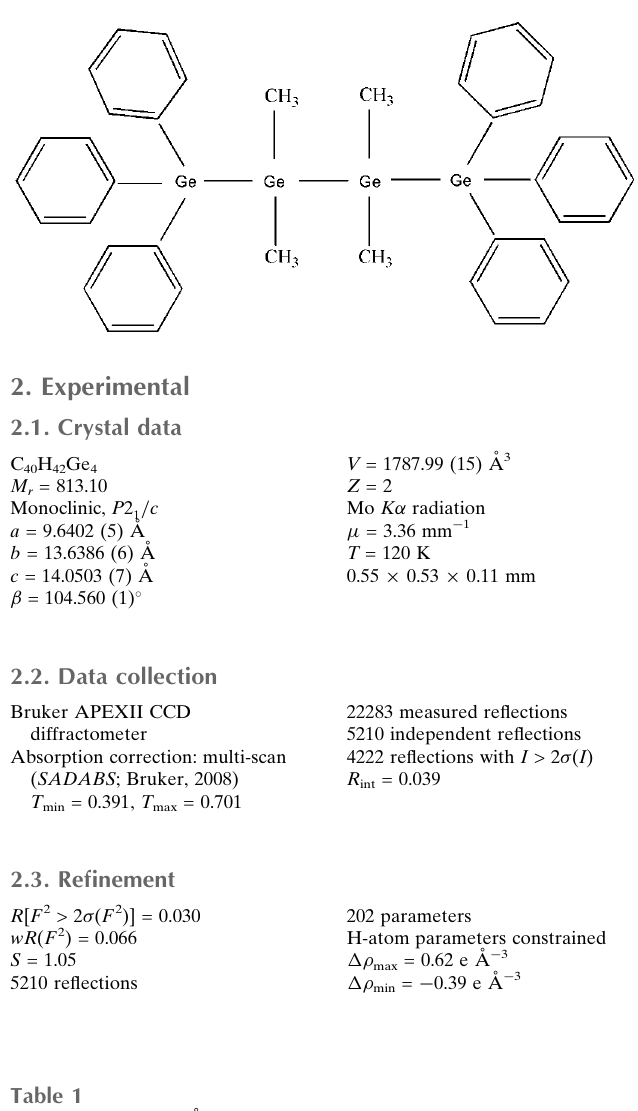
Main bond lengths (A˚ ) in organo-substituted